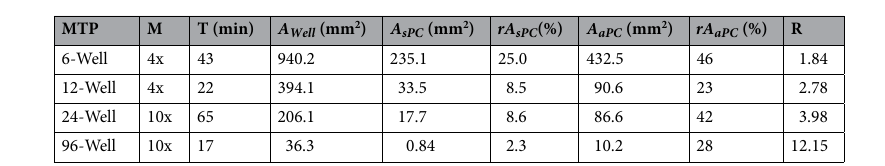
Table 1. Comparison between areas observable in phase contrast between standard and phase contrast methods. MTP Micro titer plate, M Magnification, T Imaging time per well, A Well Area of one well, A sPC